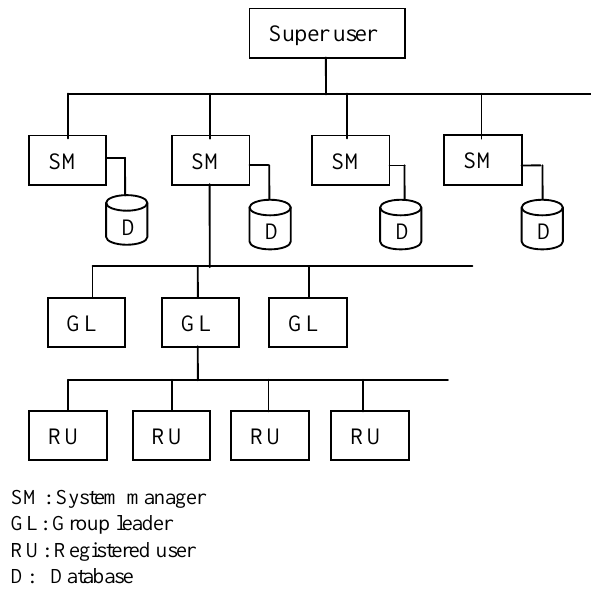
Figure 2 Structure of CEReS Gaia